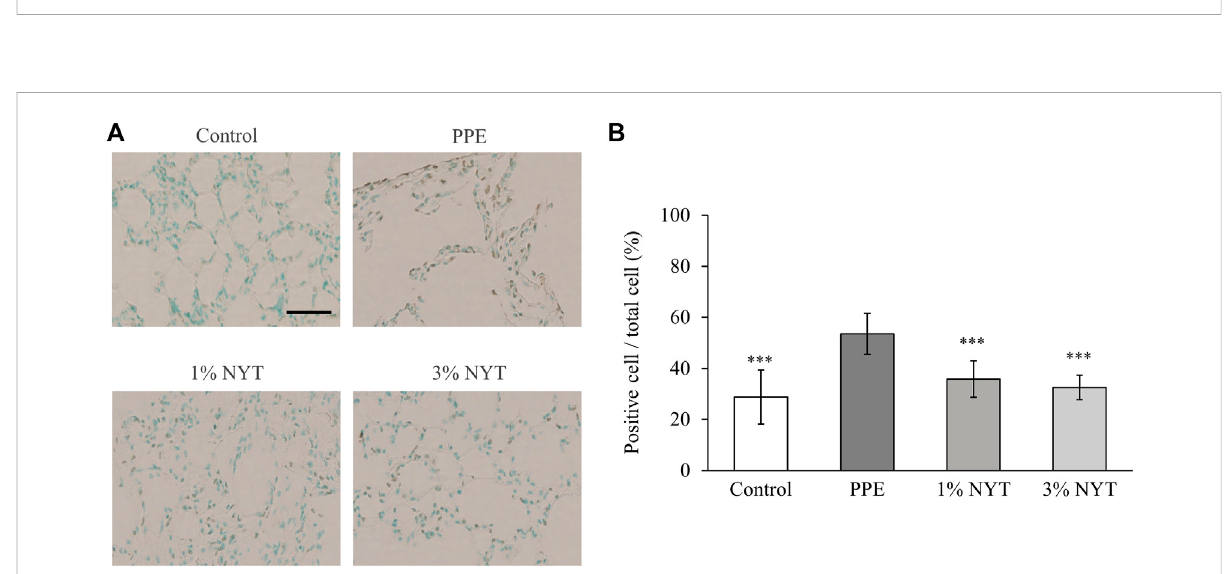
FIGURE 3 Effect of ninjin ’ yoeito (NYT) on lung tissue of PPE-induced apoptosis. (A) Lung sections stained by the TUNEL technique, counterstained with methylgreen.Scale bar=50 µm. (B) TUNEL-positivecell number expressedas percentof all nuclei counted. (Control n = 10,PPE n =11,1% NYT n = 8, 3% NYT n = 7). Values are expressed as means ± S.D. ppp p < 0.001 vs. PPE group by Tukey